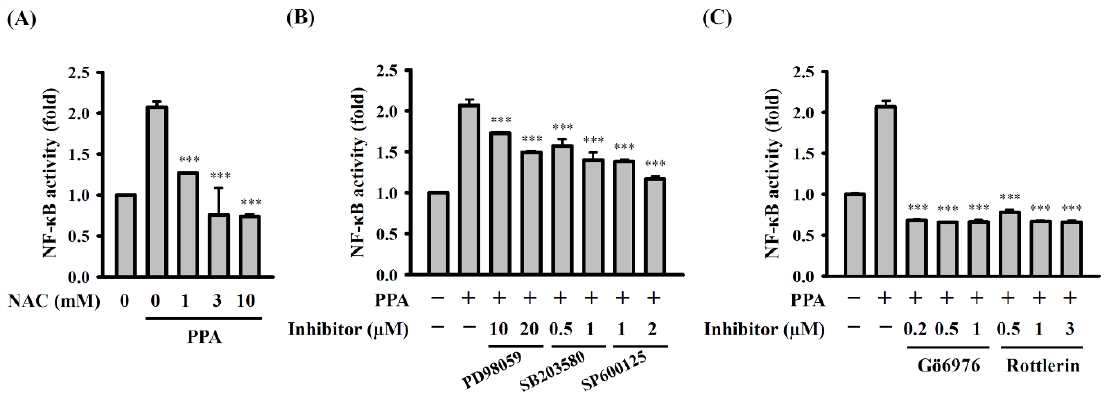
Figure 8. ROS, MAPK and PKC- α / δ function upstream of NF- κ B in PPA-activated macrophages. Effect of ( A ) NAC, ( B ) MAPK inhibitors or ( C ) PKC inhibitors on NF- κB activation in PPA-stimulated RAW-Blue cells. *** p < 0.001 compared to PPA-treated cells.